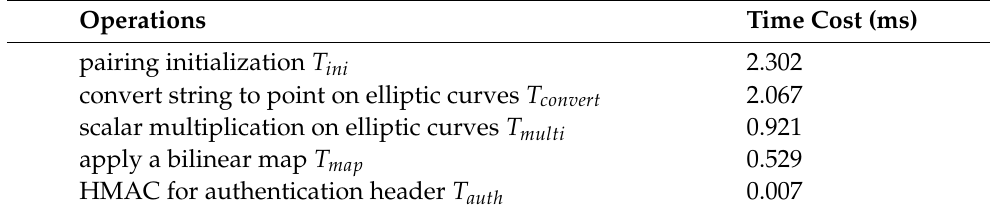
Table 3. Computational cost for cryptographic